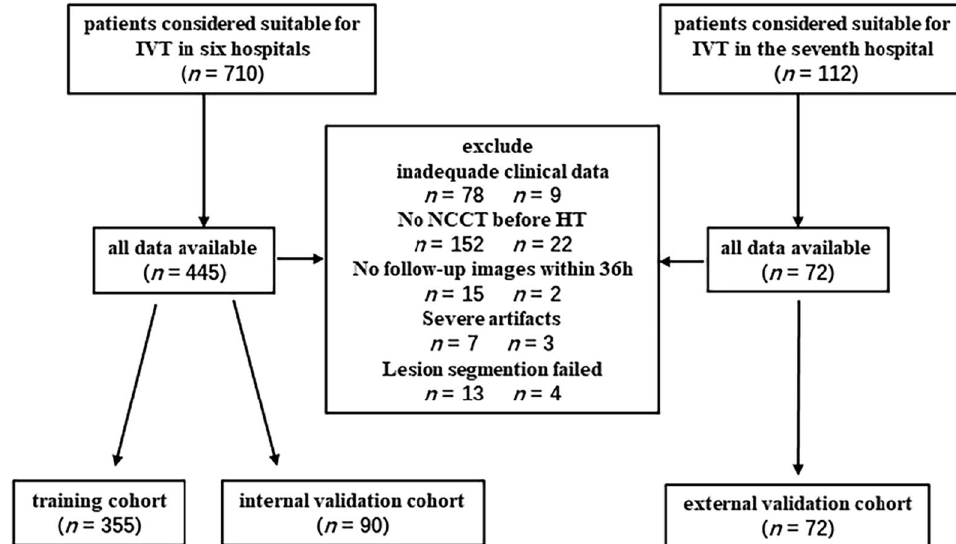
Fig. 1 Flowchart of patients’ selection (IVT, intravenous thrombolysis; HT, hemorrhagic